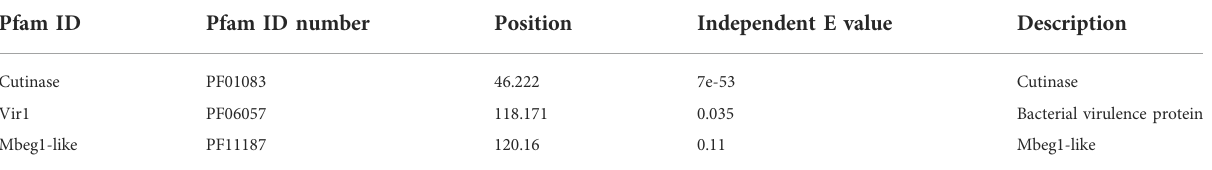
TABLE 1 Motif regions analysis.